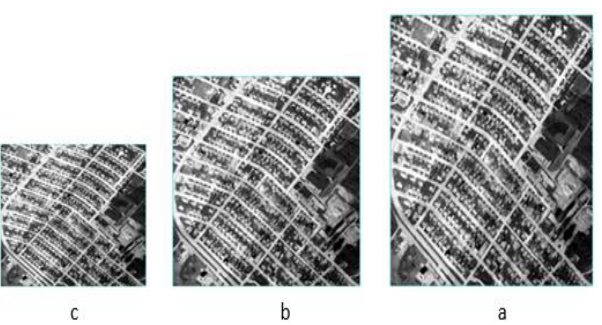
Figure 4. TIR data with ground pixel size 1-meter (a), 2-meter (b) and 4-meter (c)